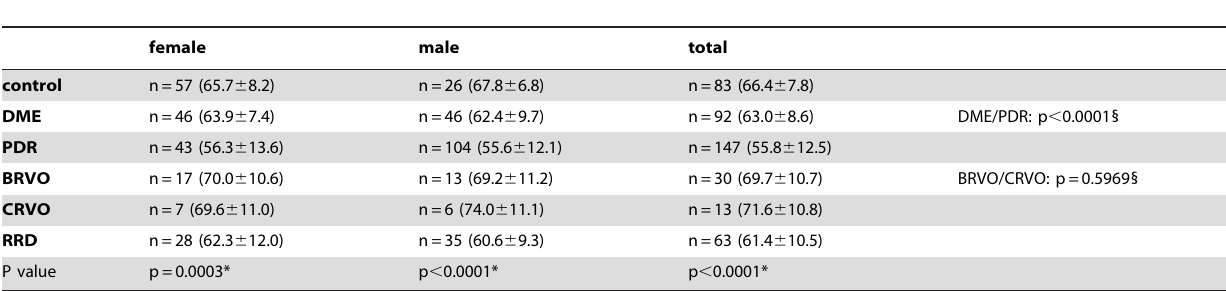
Table 1. The bibliography of enrolled patients (age: mean 6